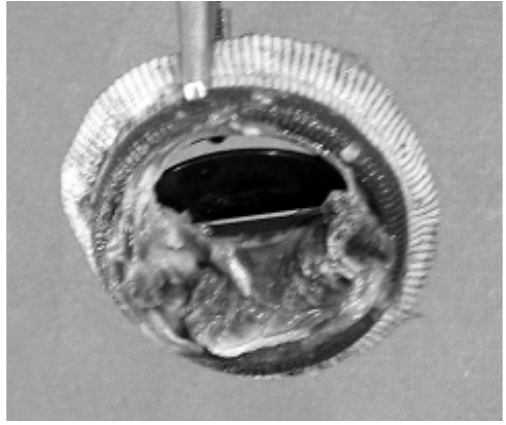
Fig. 2 - Trombose de uma prótese mecânica CarboMedics de 31 mm. Visão Frontal